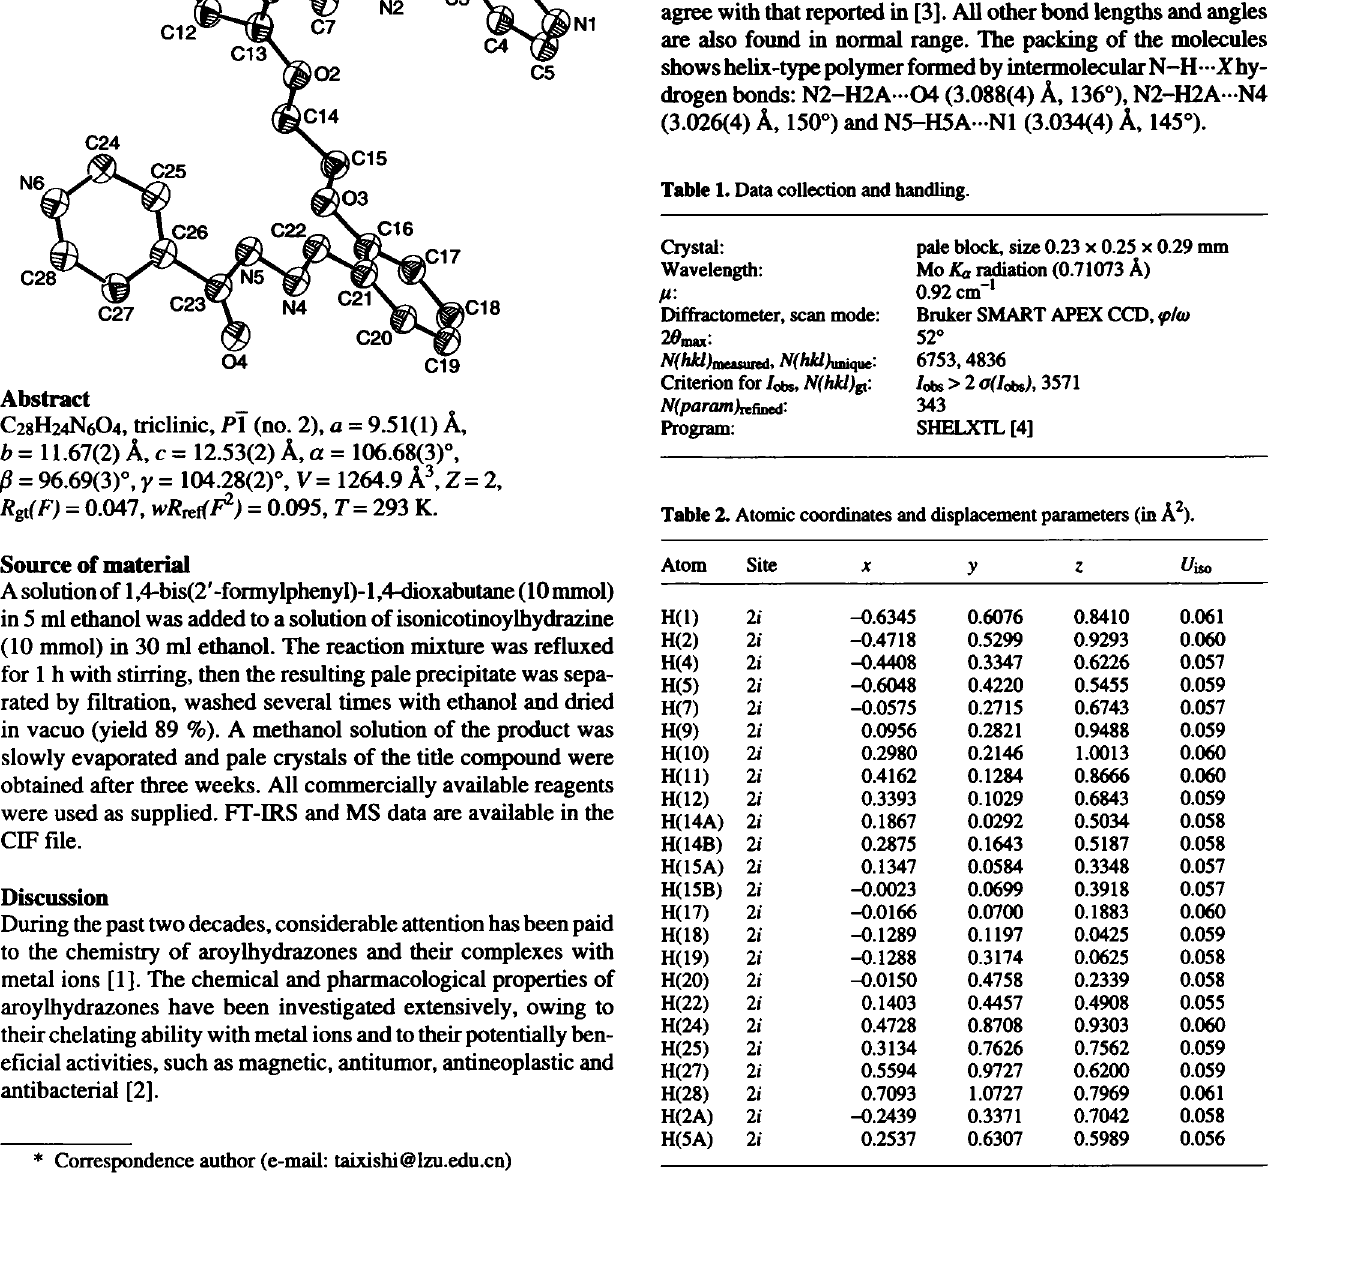
Table 2. Atomic coordinates and displacement parameters (in Â 2